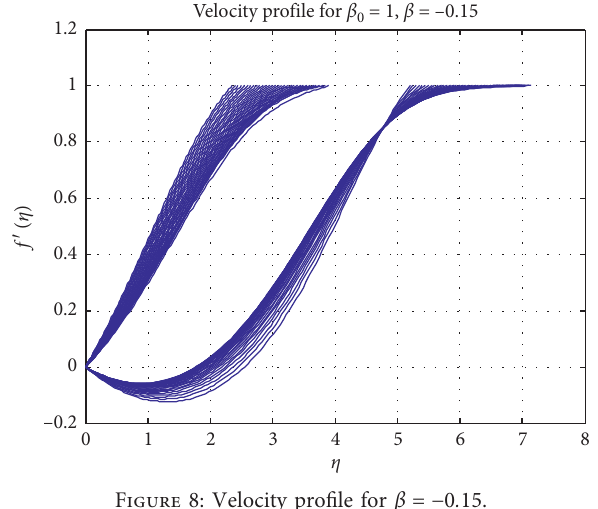
Figure 8: Velocity profile for β � − 0 . 15. Velocity profile for β